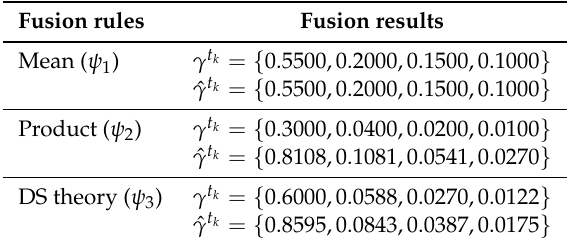
Table 1. An example of combined prediction using three fusion